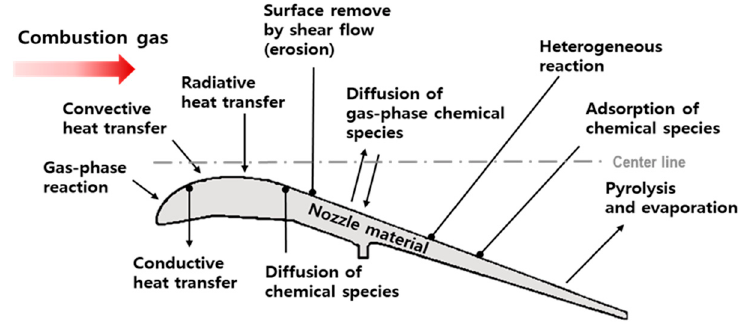
Figure 1. Physical and chemical processes associated with rocket nozzle erosion.